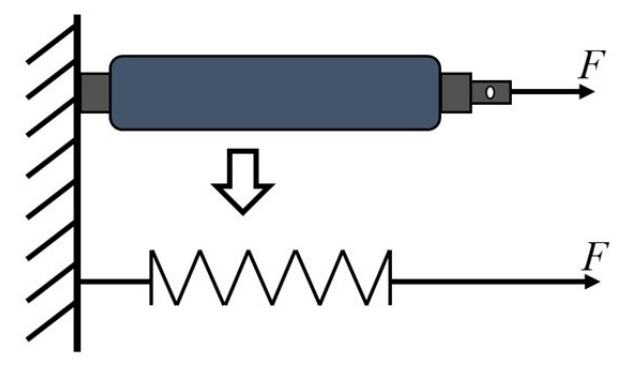
Figure 11. Comparison of PAM and spring